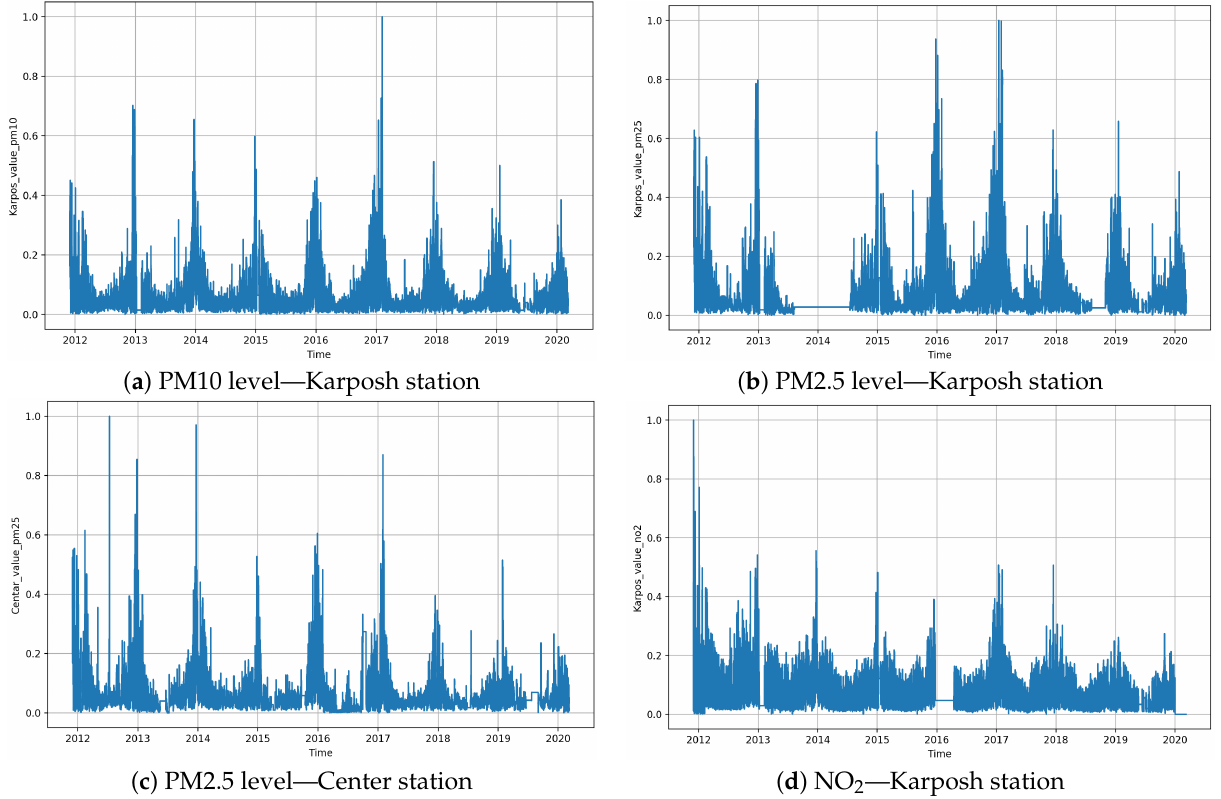
Figure 2. Exploration of the seasonality and trend in concentration levels taken from the Karposh and Center measurement